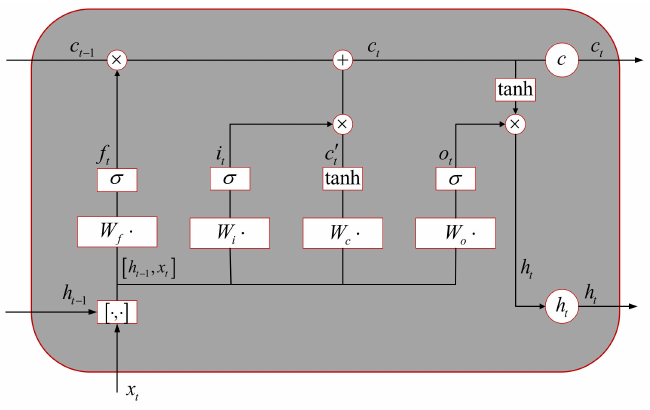
Figure 8. Schematic of the LSTM neuron